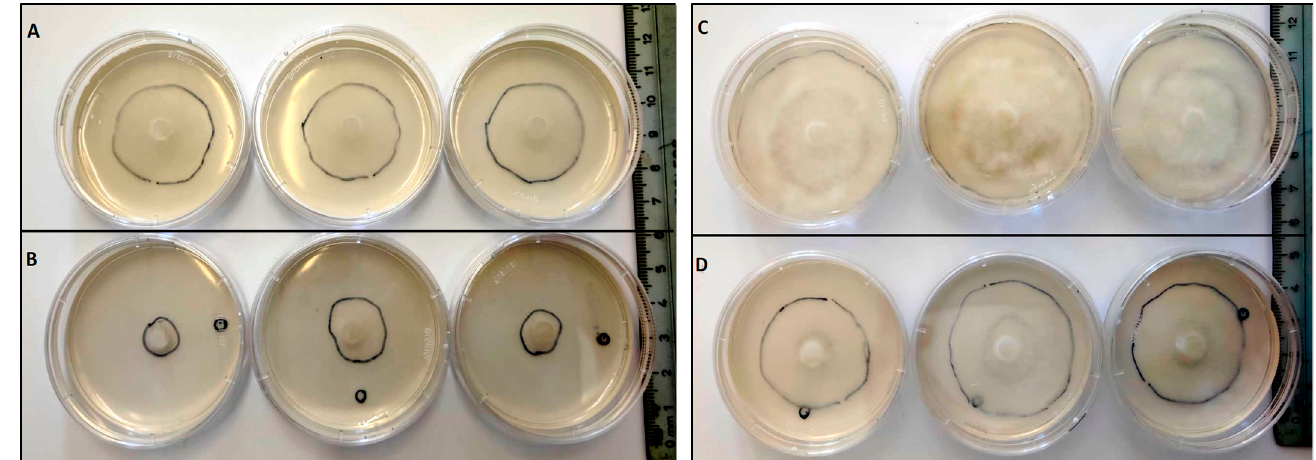
Figure 4. Mycelia of P. cinnamomi growth in PDA medium under di ff erent conditions (3 Petri plates out of n are shown as representative of the assay). ( A ): Control treatment with bu ff er solution and P. cinnamomi mycelial growth after 24 h. ( B ): Cast_Gnk2-like pure protein (250 µL/plate and 0.5 mg/mL) and P. cinnamomi mycelial growth after 24 h. ( C ): Control treatment with bu ff er solution and P. cinnamomi mycelial growth after 48 h. ( D ): Cast_Gnk2-like pure protein (250 µL/plate and 0.5 mg/mL) and P. cinnamomi mycelial growth after 48 h.